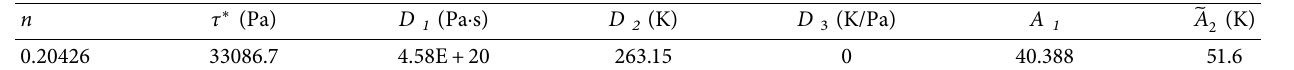
Figure 1: 3D product mesh model. Table 1: The parameters of Cross-WLF viscosity